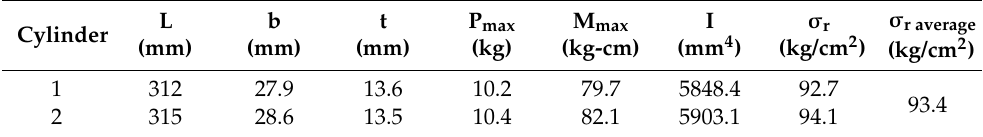
Table 2. Results of the experiment tension on the fibrocement panel. Cylinder